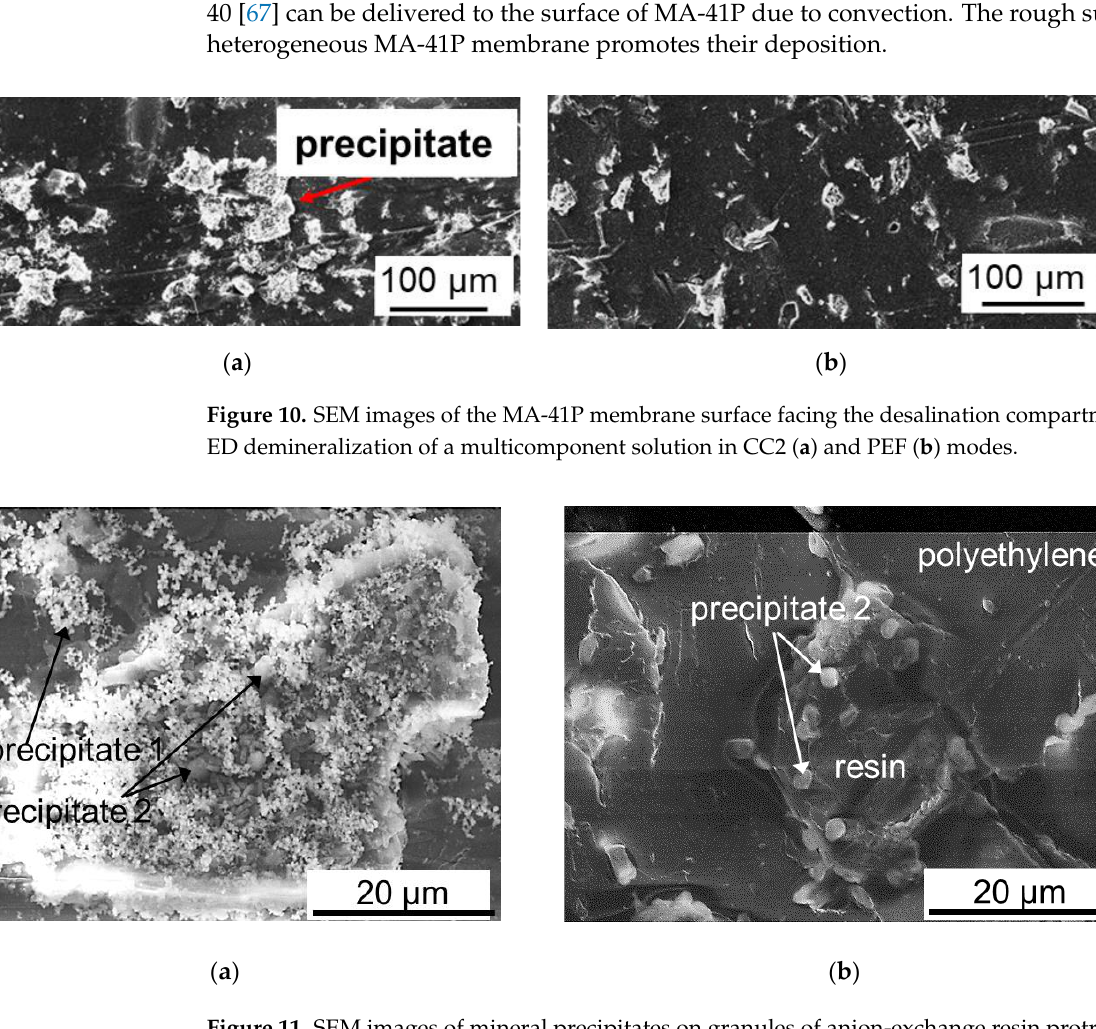
Figure 11. SEM images of mineral precipitates on granules of anion-exchange resin protruding on the surface of MA-41P after ED demineralization of a multicomponent solution in С C2 ( а ) and PEF ( b ) modes .